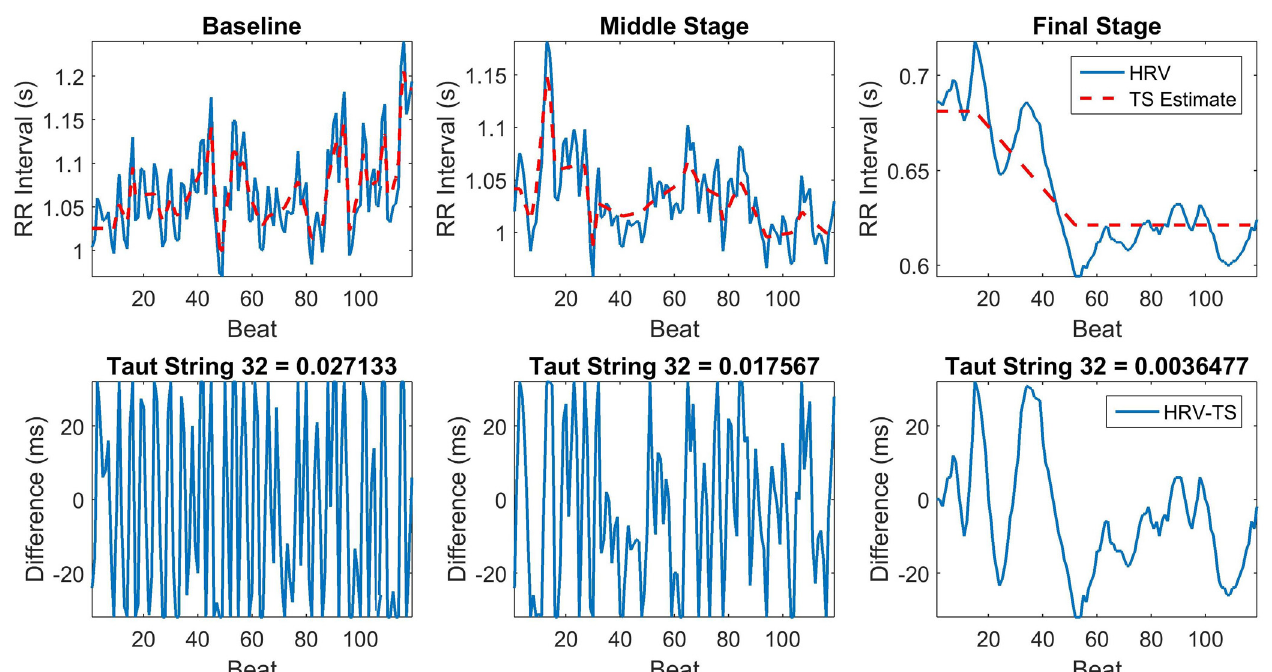
Fig 4. Top row. the HRV signals and their taut string estimates for a window at baseline, middle stage and final stage. Bottom row : the differences between the HRV waveforms and their taut string estimates. The figure also shows the value of the Taut String 32 feature at each